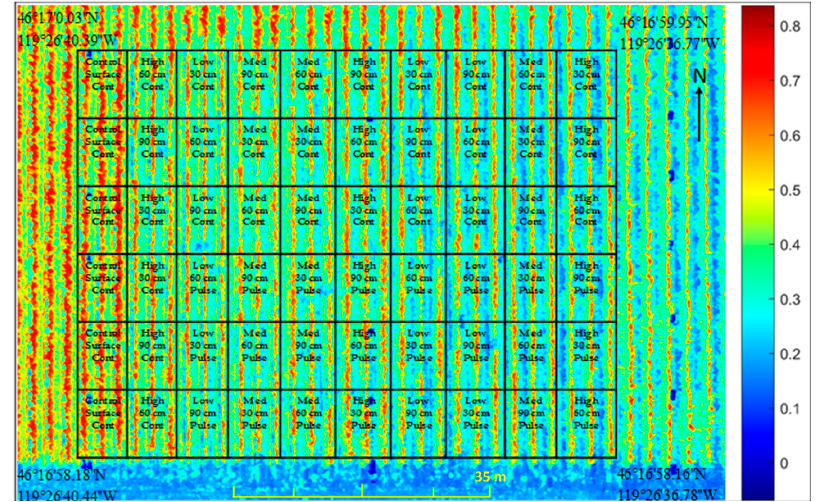
Figure 1. Green normalized difference vegetation index (GNDVI) image of the experimental site in the Kiona vineyards describing the irrigation treatments. Irrigation rate was 100% (standard irrigation rate) for the Control; and 60% (High), 30% (Medium), and 15% (Low) of the standard irrigation rate. The subsurface irrigation depths were 30, 60, and 90 cm. ‘Cont’ and ‘Pulse’ refer to continuous and pulse irrigation, respectively. The GNDVI scale is given on the right side.